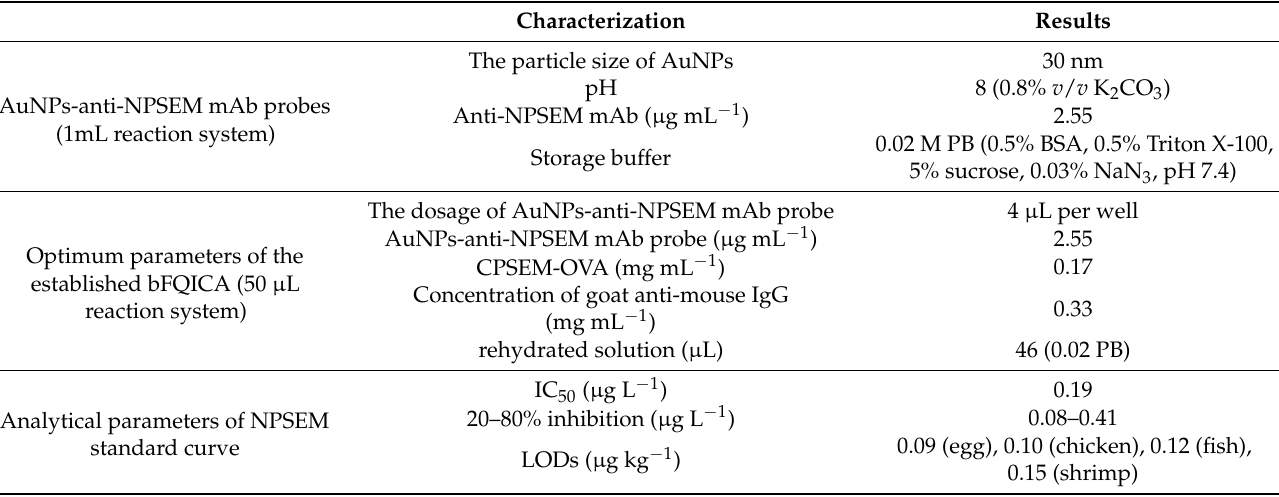
Table 1. Analytical parameters of the bFQICA for the detection of